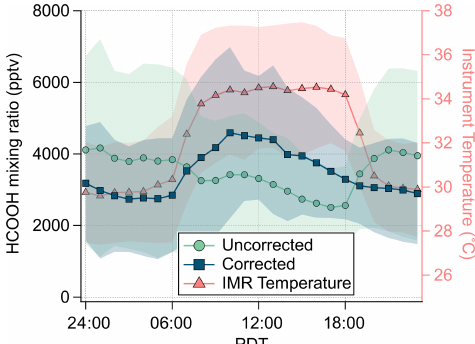
Figure 6. Campaign average diurnal mixing ratio of HCOOH (un- corrected and corrected for IMR temperature) and IMR tempera- ture. Shading represents 1 standard